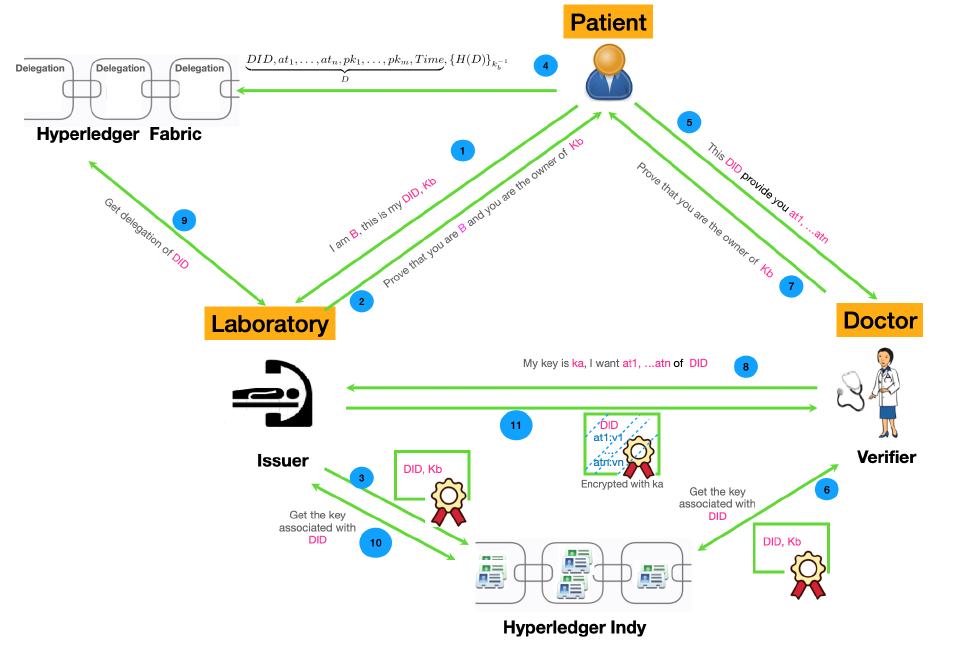
Figure 3. EHR access control delegation based on Indy and